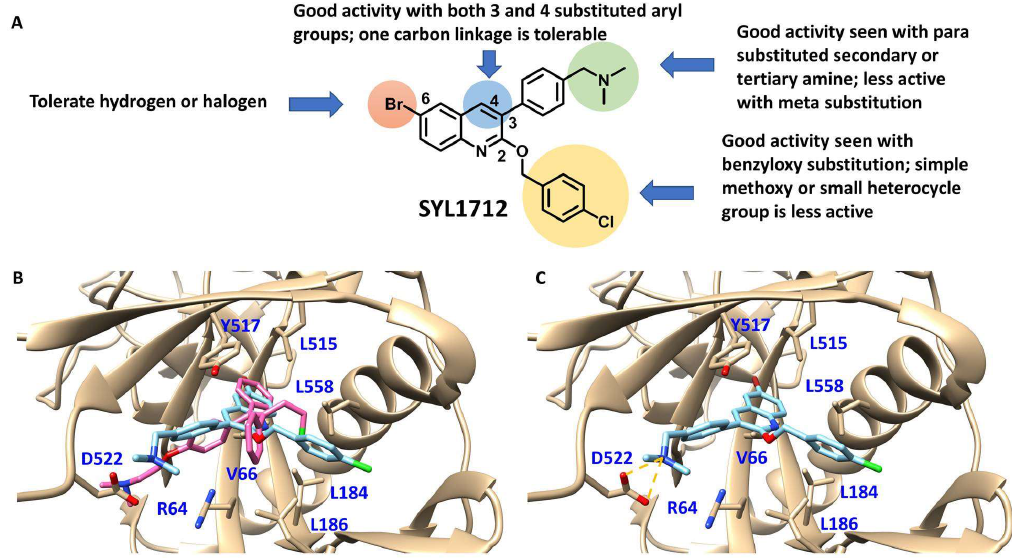
Figure 4. Structure activity relationship (SAR) of diarylquinoline compounds against EBOV ( A ) Summary of the SAR analysis the diarylquinoline compounds as Ebola virus entry inhibitors. ( B , C ) Predicted binding mode of SYL1712 with Ebola glycoprotein by molecular docking (PDB code: 5JQ7). ( B ) Superposition of SYL1712 (cyan) with toremifene (pink) shows similar binding orientations at the interface between GP1 and GP2; ( C ) SYL1712 (cyan) forms both hydrophobic interactions (V66, Y517, L558, L184 and L186) and electrostatic interactions (D522) with EBOV GP ( C